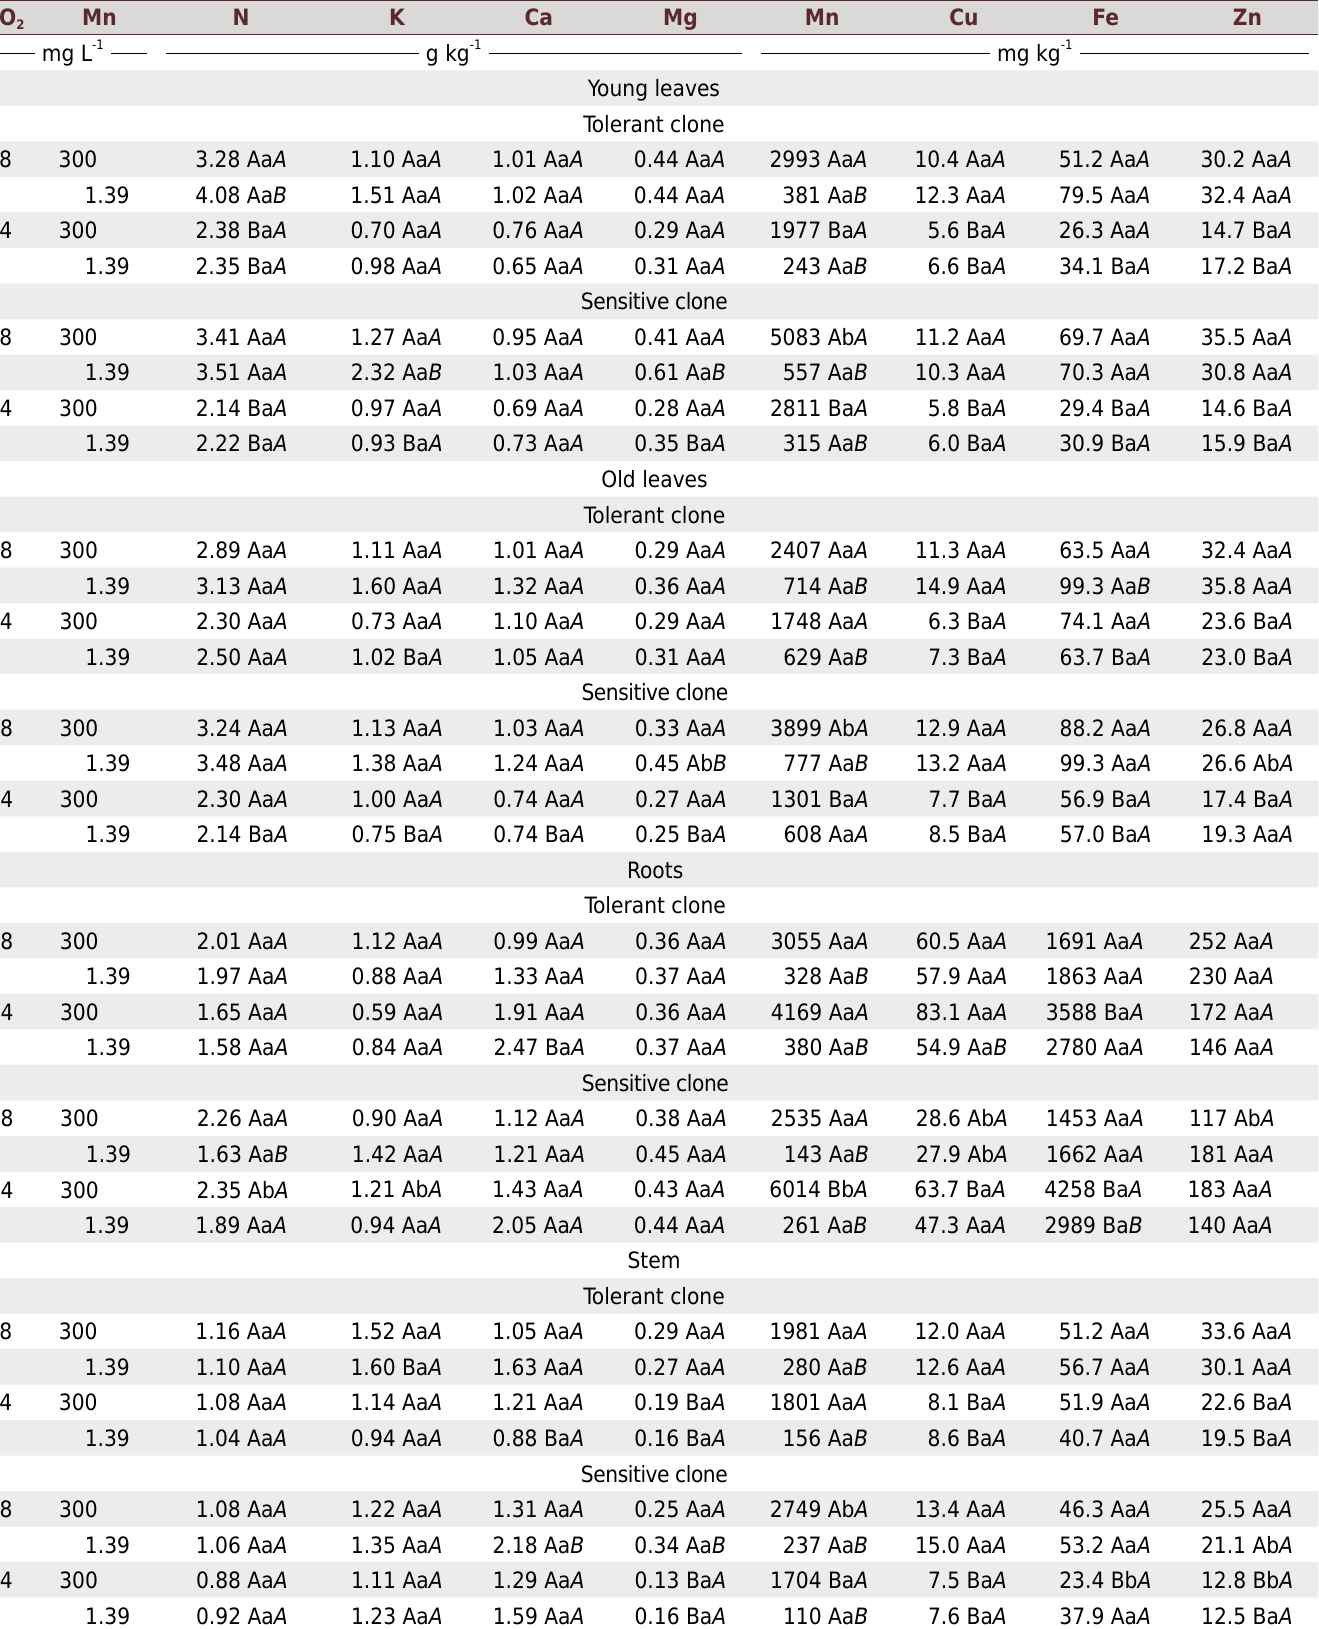
Table 1. Nutrient contents in young and old leaves, roots, and stem of two Eucalyptus clones, tolerant (2719) and sensitive (1213) to VRDSD, subjected to different concentrations of Mn (300 mg L -1 and 1.39 mg L -1 ) and O 2 (normoxia: 8 mg L -1 and hypoxia: 4 mg L -1 ) O